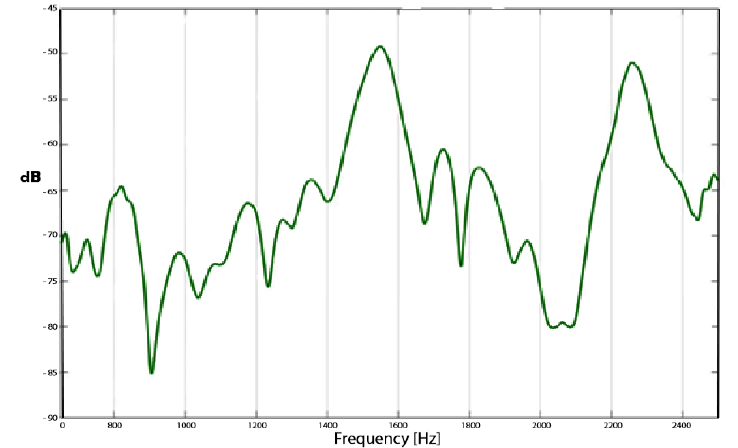
Figure 11. Typical generated FRF of the gearbox for OMA at 3000 rpm.